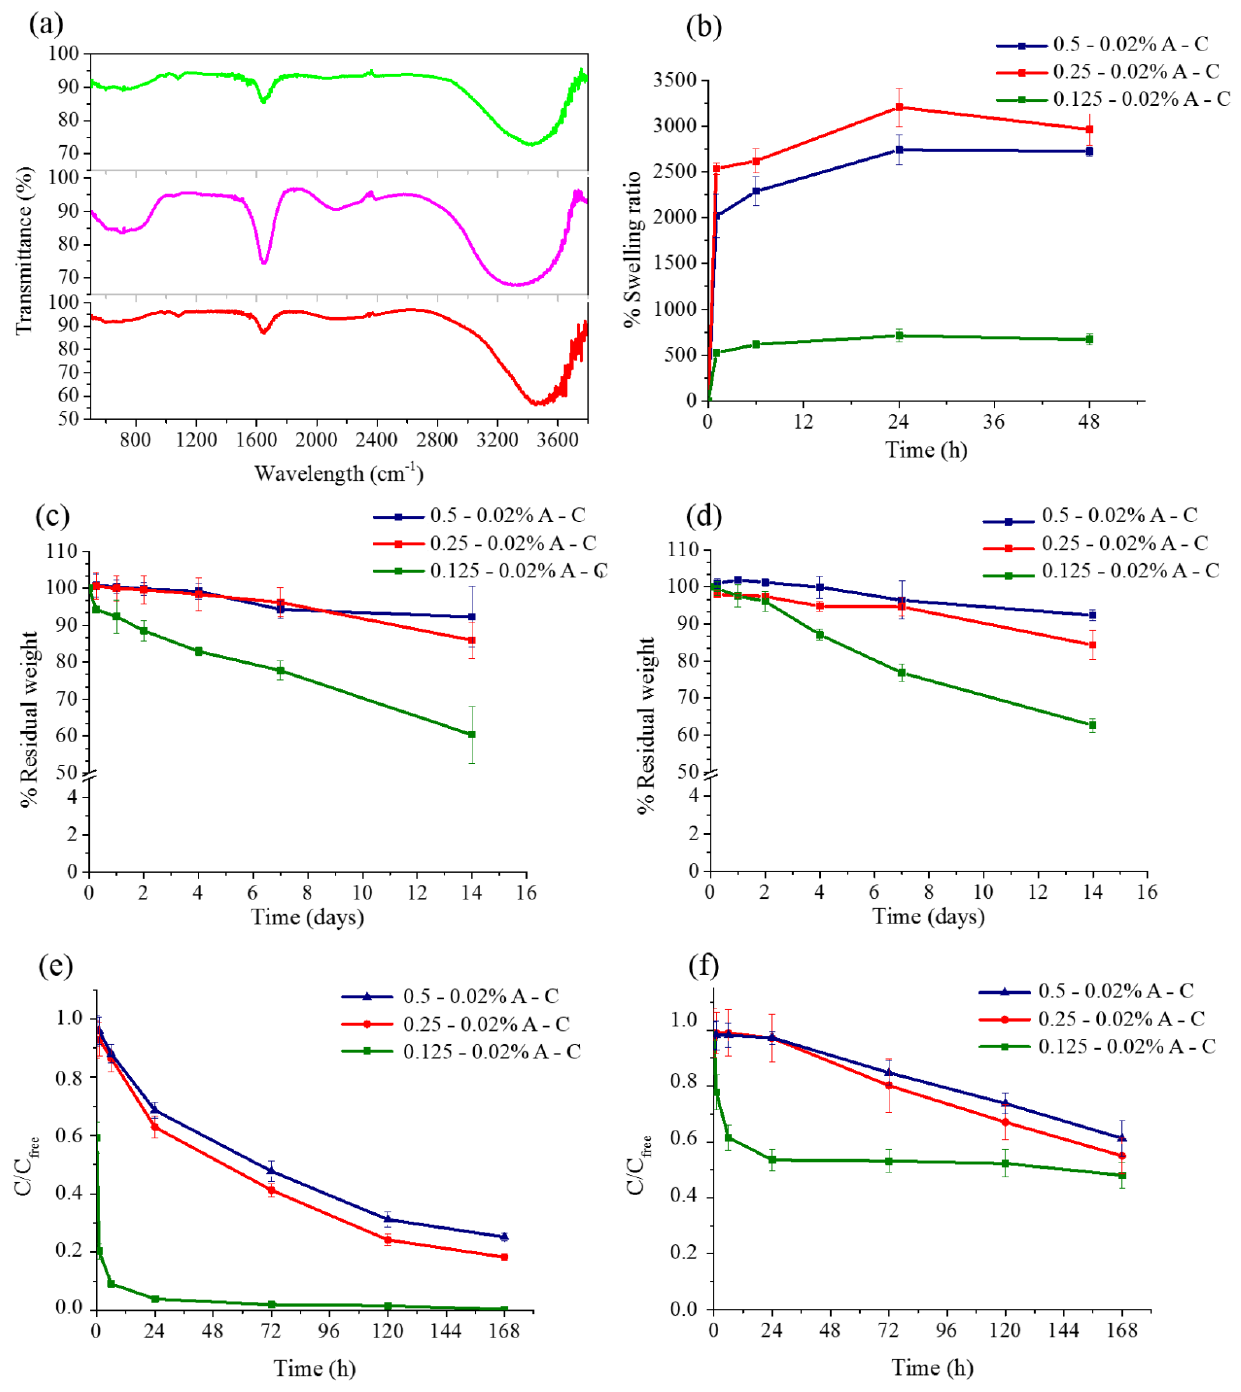
Figure 2. ( a ) FTIR spectra of agarose (green curve), collagen (pink curve), and 0.25–0.02% A-C (red curve) hydrogels. ( b ) Swelling behavior of the A-C hydrogels kept for 2 days in PBS at 37 °C. ( c , d ) Degradation curves up to 2 weeks of the A-C hydrogels either in PBS ( c ) or in DMEM ( d ). Diffusion tests performed up to one week with hyaluronic acid-FITC ( e ) and transferrin-TRITC ( f ).